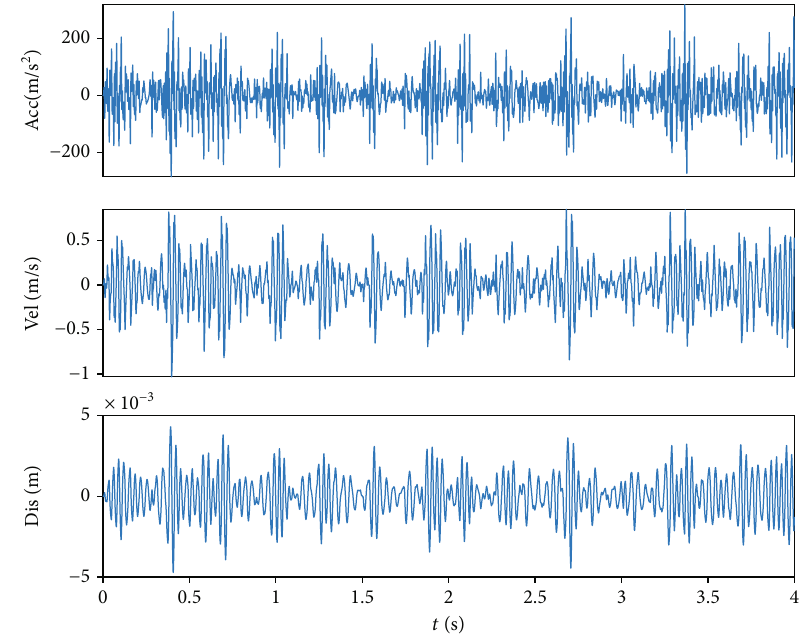
Figure 7: Filtered vibration signals of the folding fi n at the fi rst measurement point.